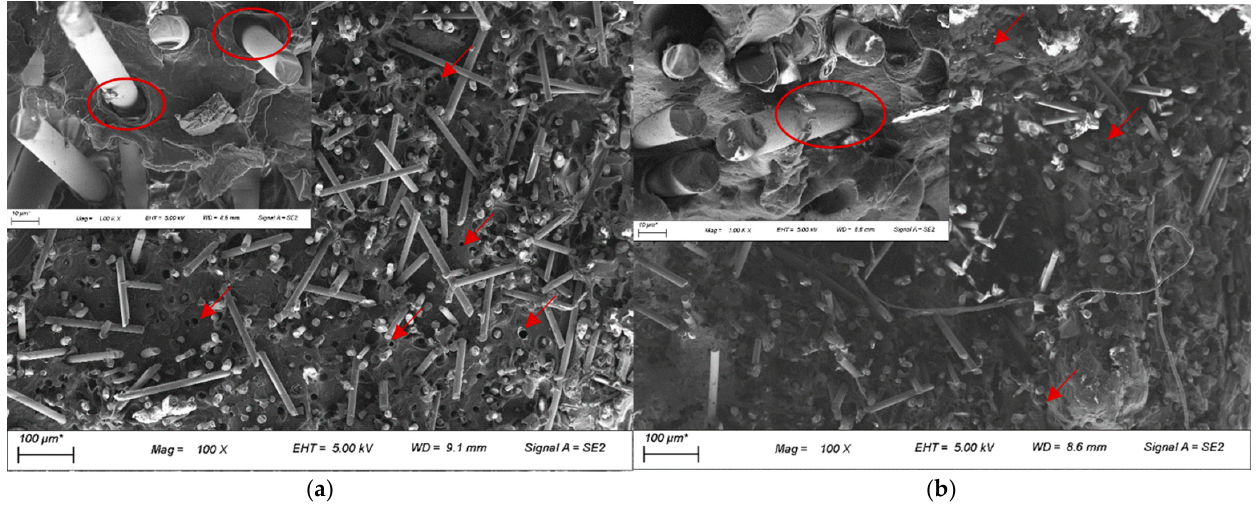
Figure 9. FESEM images with inserts at higher magnification of the short BF-PP composites ( a ) without compatibiliser and ( b ) with compatibiliser. Note: Fibre-matrix gap highlighted by red circle and holes highlighted by red arrows.